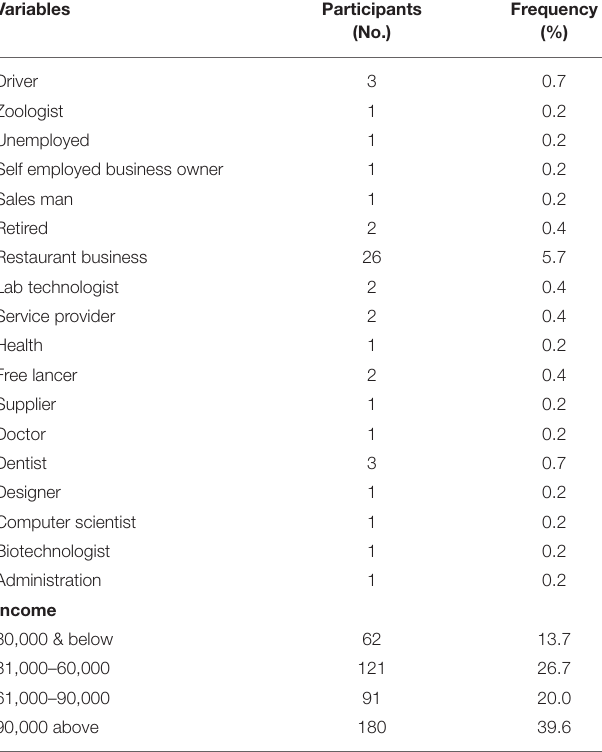
TABLE 1 | Sociodemographic characteristics of the participants. Variables